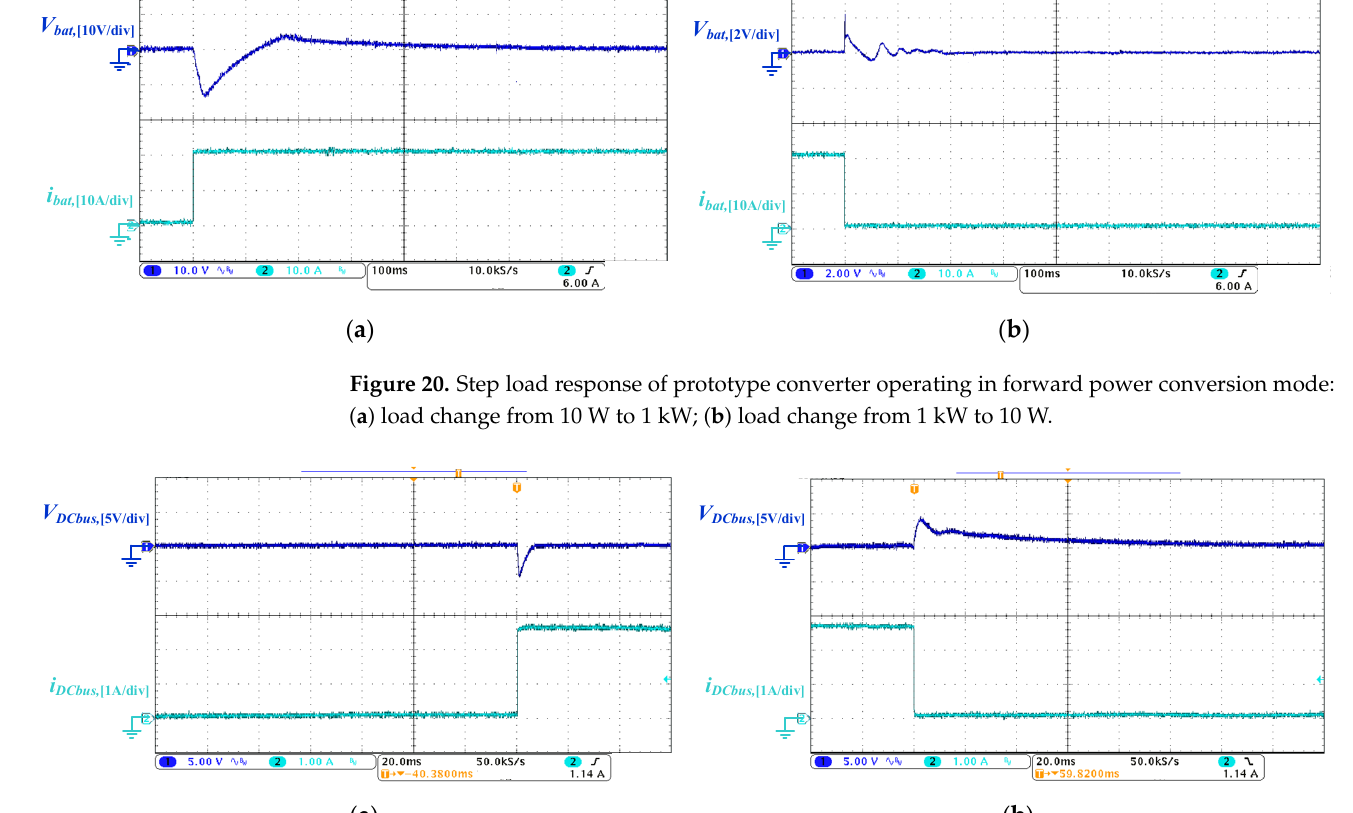
Figure 21. Step load response of prototype converter operating in backward power conversion mode: ( a ) load change from 10 W to 1 kW; ( b ) load change from 1 kW to 10 W.